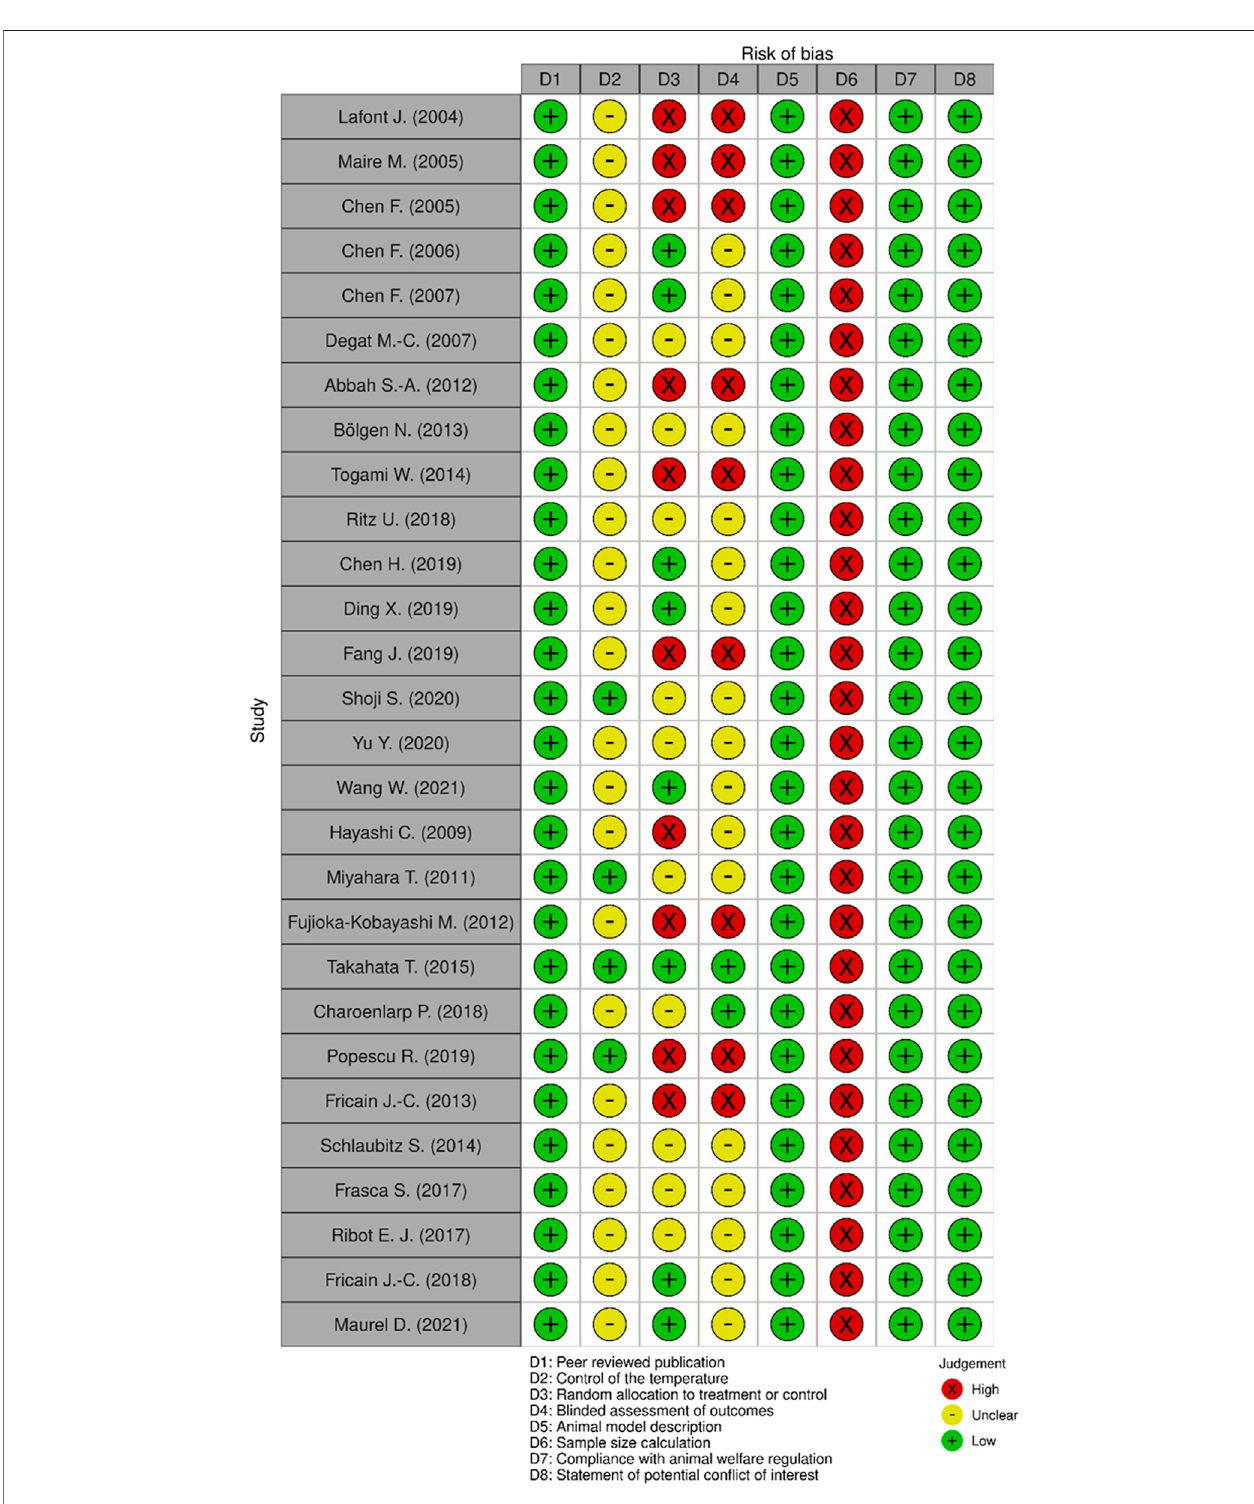
Frontiers in Bioengineering and Biotechnology |